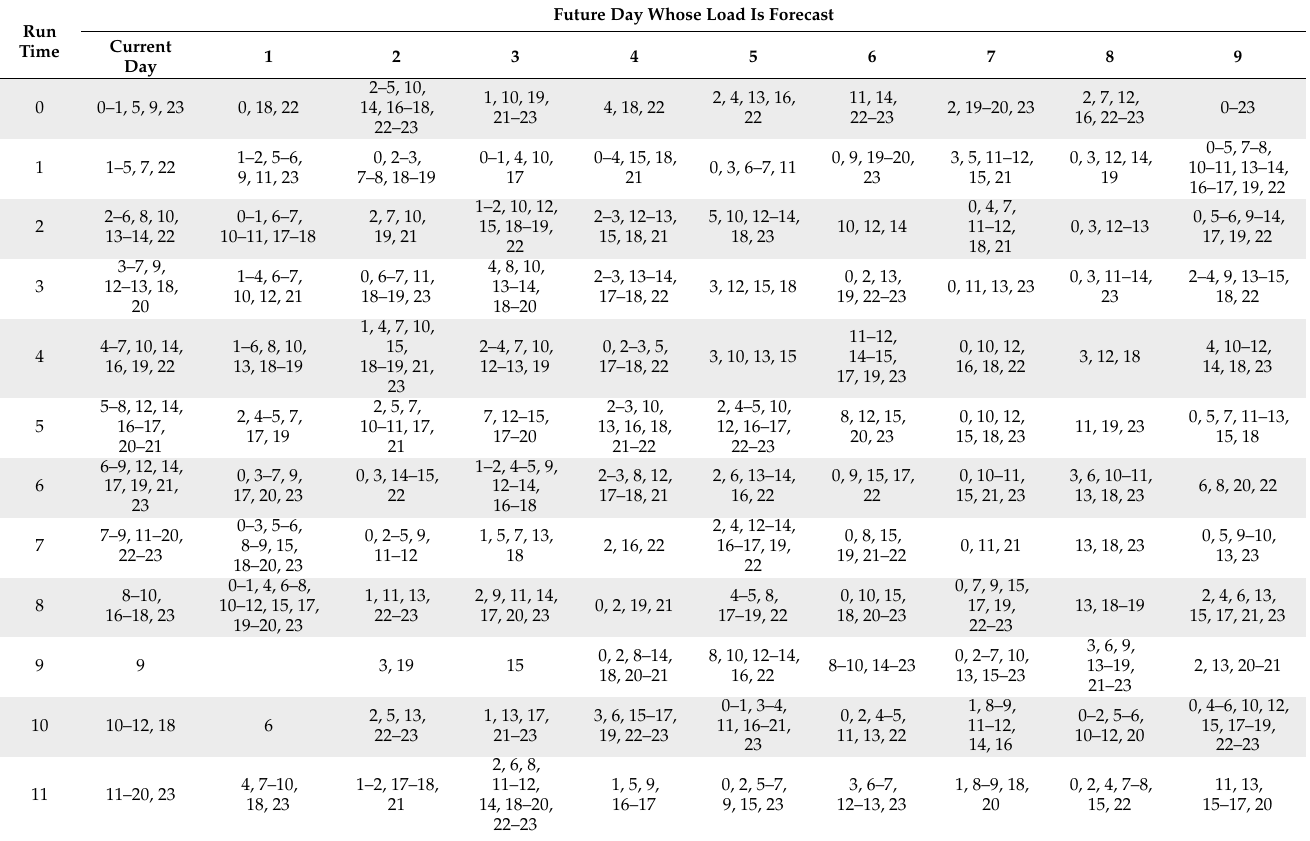
Table 3. Schedule for combined